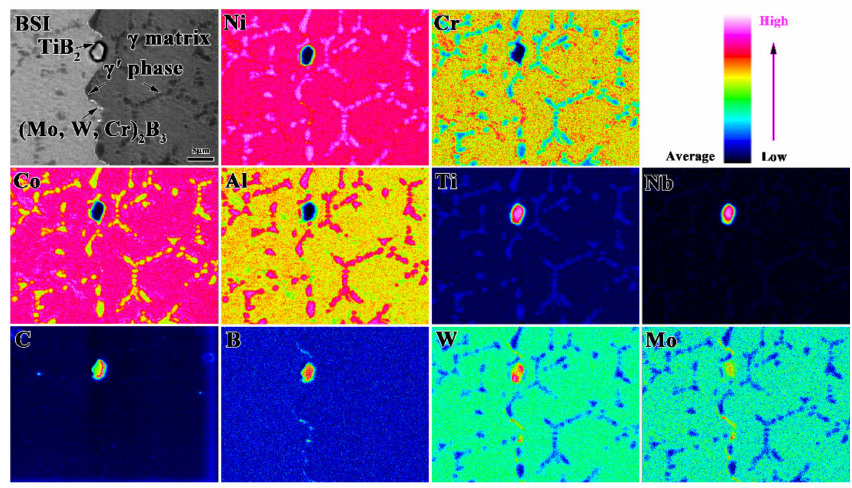
Figure 12. EPMA analyses of the microstructure on serrated grain boundaries under isothermal heat treatment under FC